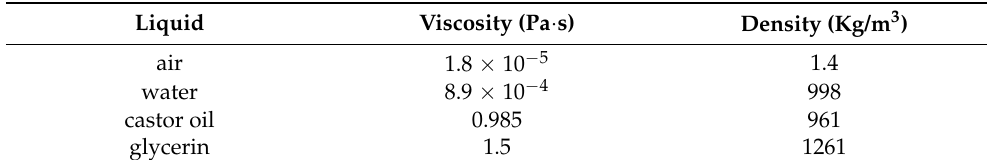
Table 2. Properties of viscous fluids.